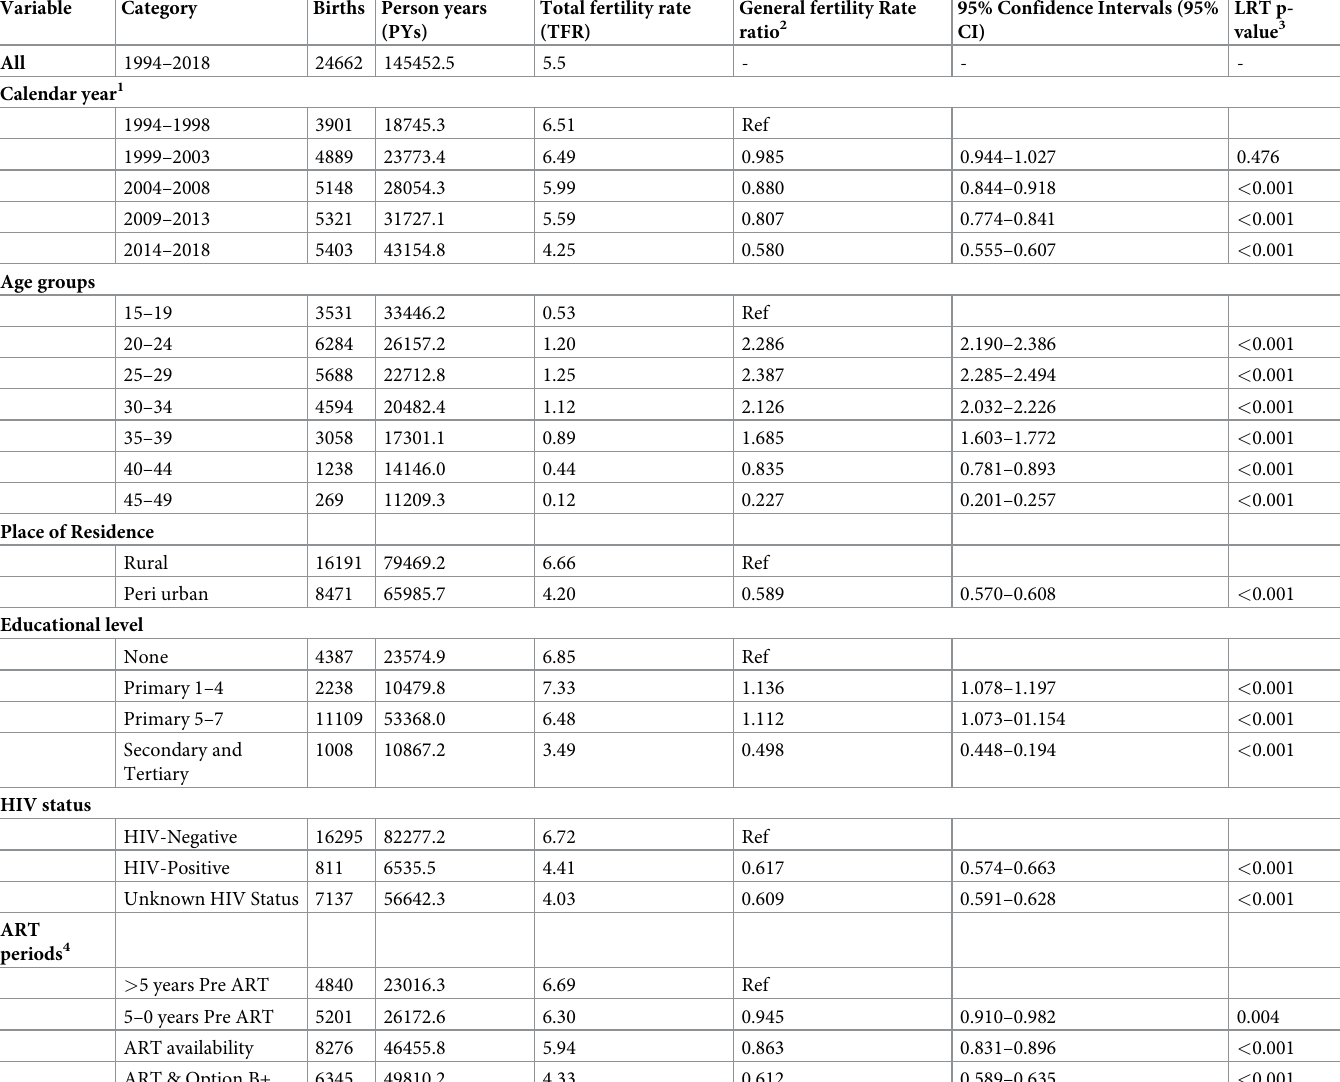
Table 1. Total fertility rates (TFR) among women aged 15–49 from January 1994 to December